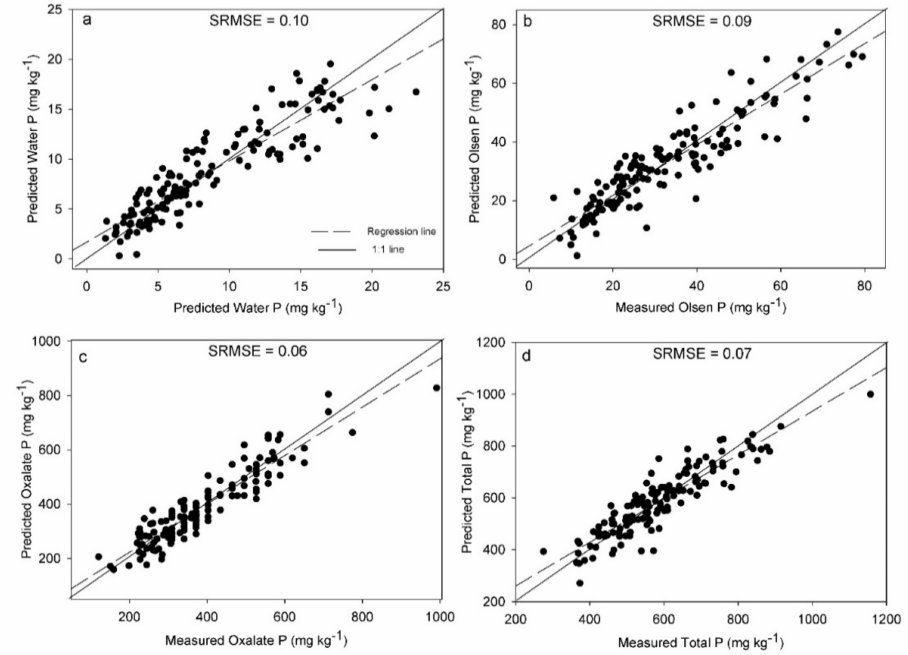
Figure 5. Partial least squares regression and variable selection results of the best LIBS-vis-NIRS models, presented as the predicted versus reference measurements for water-extractable P ( a ), Olsen P ( b ), Oxalate-extractable P ( c ) and total P ( d ) measurements. Standard root mean square error of cross validation (SRMSE) is also included in each